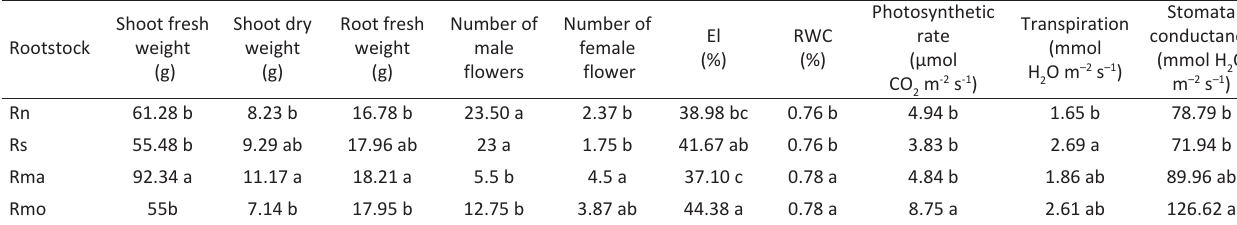
Rn= nongrafted ( Cucumis sativus var. DavosII);